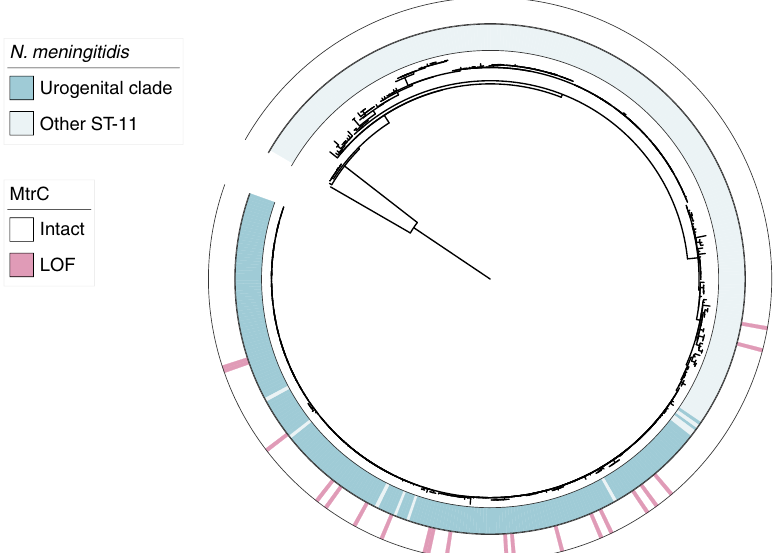
Fig. 4 mtrC LOF mutations are enriched in a lineage of ST-11 urogenitally-adapted N. meningitidis . A core-genome maximum likelihood phylogeny based on 25045 SNPs was estimated of all North American ST-11 N. meningitidis strains from PubMLST ( n = 456; accessed 2019 – 09 – 03) rooted with meningococcal reference genome MC58. Membership in the ST-11 urogenital clade (dark blue) is de fi ned as in Retchless et al. 44 . Genomes with mtrC LOF mutations are indicated in pink. Branch length represents substitutions per